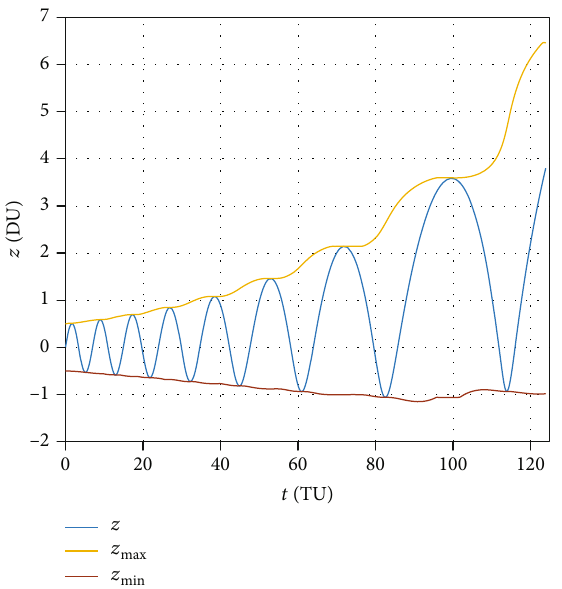
Figure 2: Schematic diagram of changes in the z -component during a multirevolution